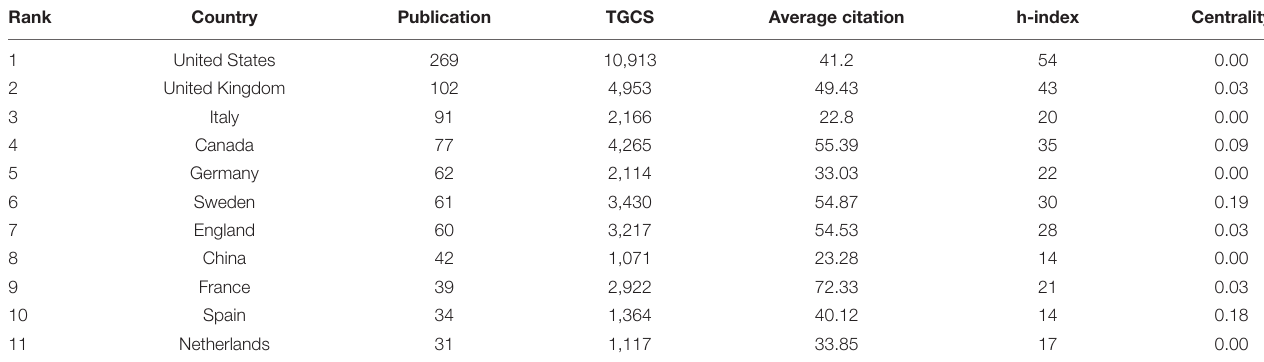
TABLE 1 | Top 11 producing countries studied by ARNI in the cardiovascular system.